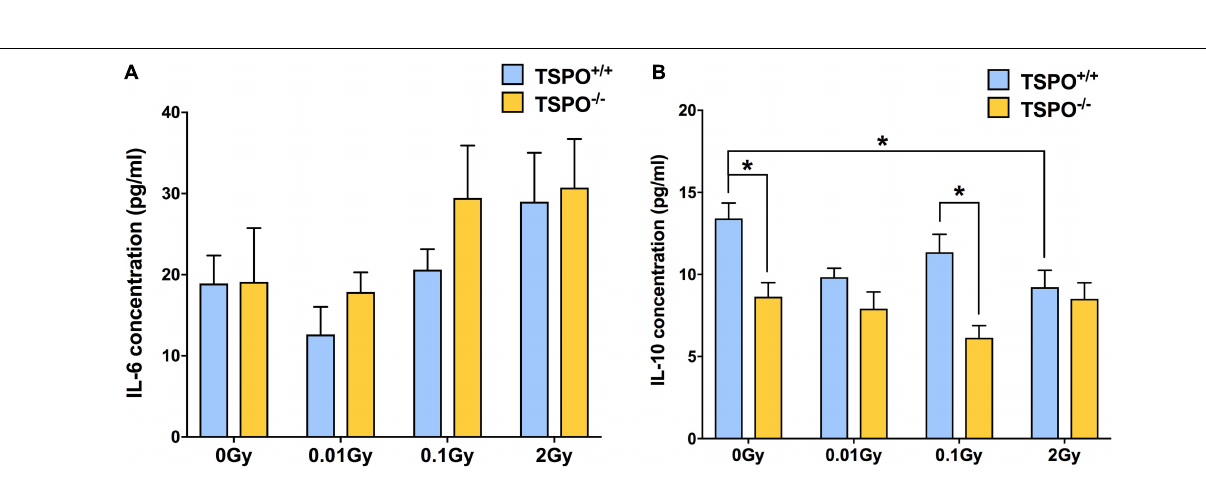
Frontiers in Cell and Developmental Biology |